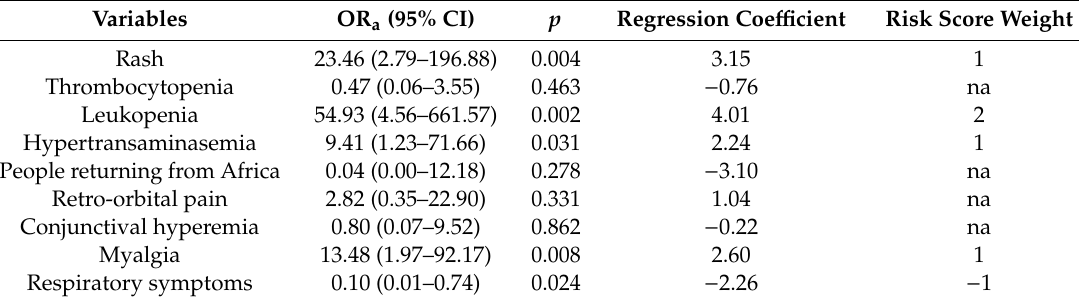
Table 3. Multivariable model and risk score for